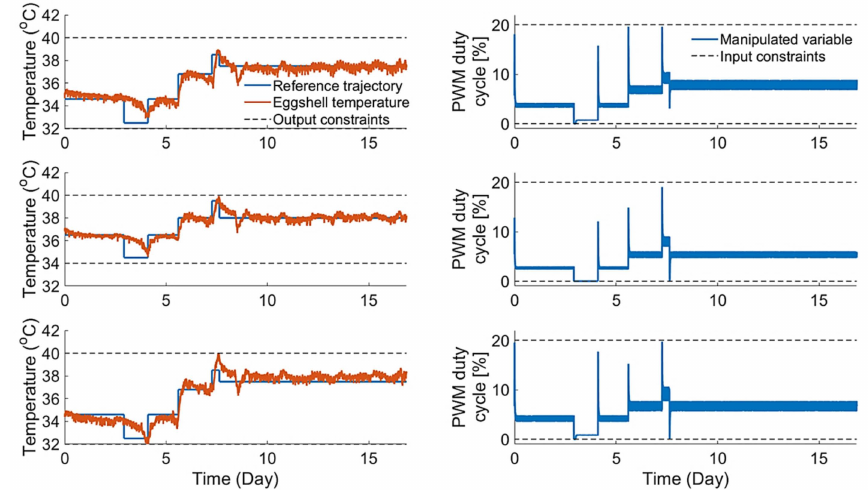
Figure11. ExampleoftheimplementationresultsofthedevelopedMPCstoregulatetheeggshelltemperatures at three different regions, I (upper graphs), II (middle graphs) and II (lower graphs)